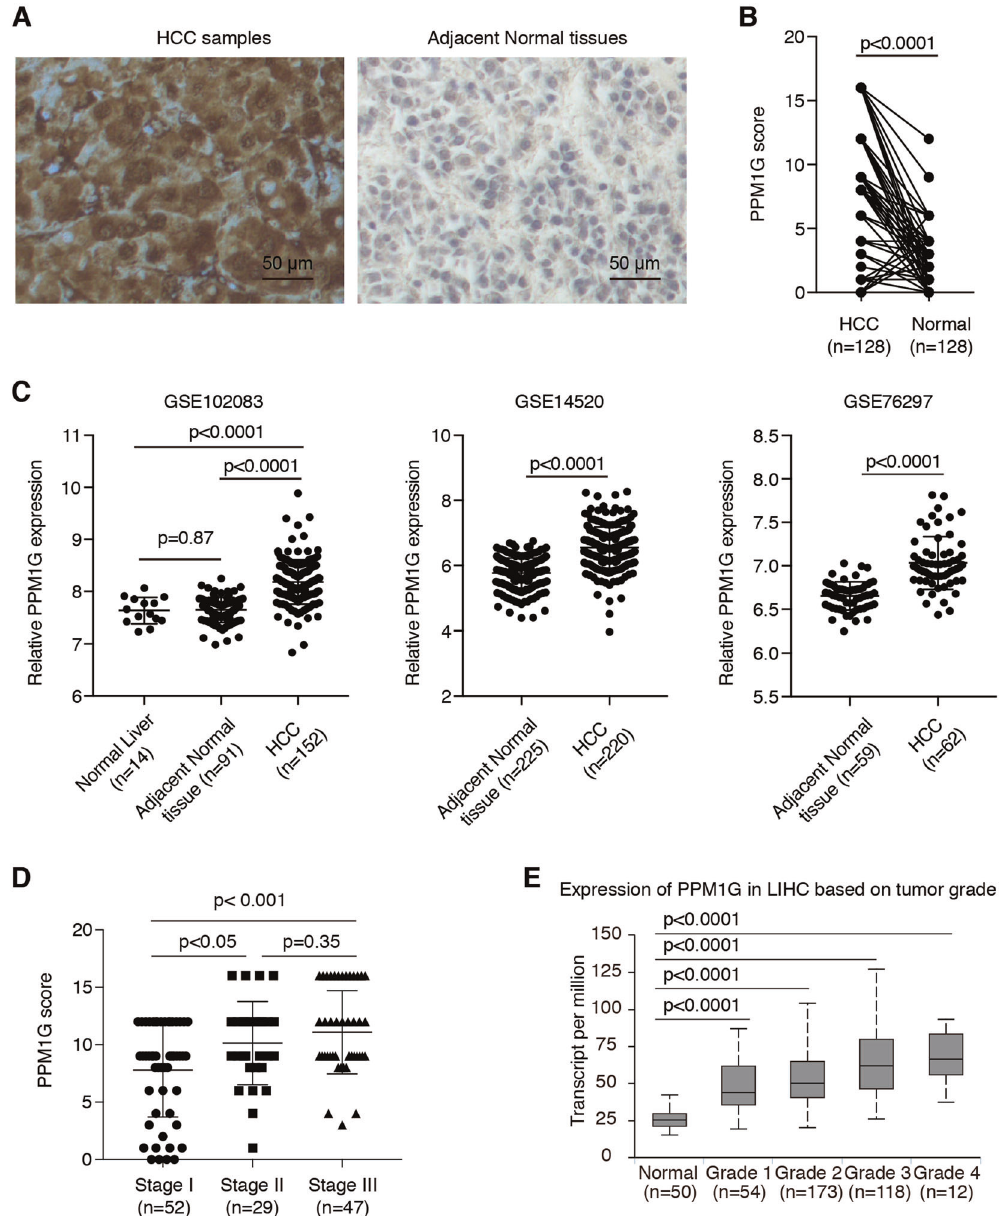
Fig. 1 PPM1G was highly expressed in HCC cells. A – B PPM1G was highly expressed in the HCC samples as compared with adjacent normal tissues. The IHC experiments were performed in HCC samples and adjacent normal tissues using antibodies against PPM1G ( A ). The statistical comparison of the PPM1G levels between HCC samples and adjacent normal tissues was shown ( B ). C The mRNA levels of PPM1G were signi fi cantly higher in HCC tissues than adjacent normal tissues or normal liver tissues in the GEO database. D The levels of PPM1G were increased in the advanced stages of HCC. The PPM1G scores in the different stages of HCC were shown. E The mRNA levels of PPM1G were highly expressed in HCC. The levels of PPM1G in the TCGA-LIHC cohort were